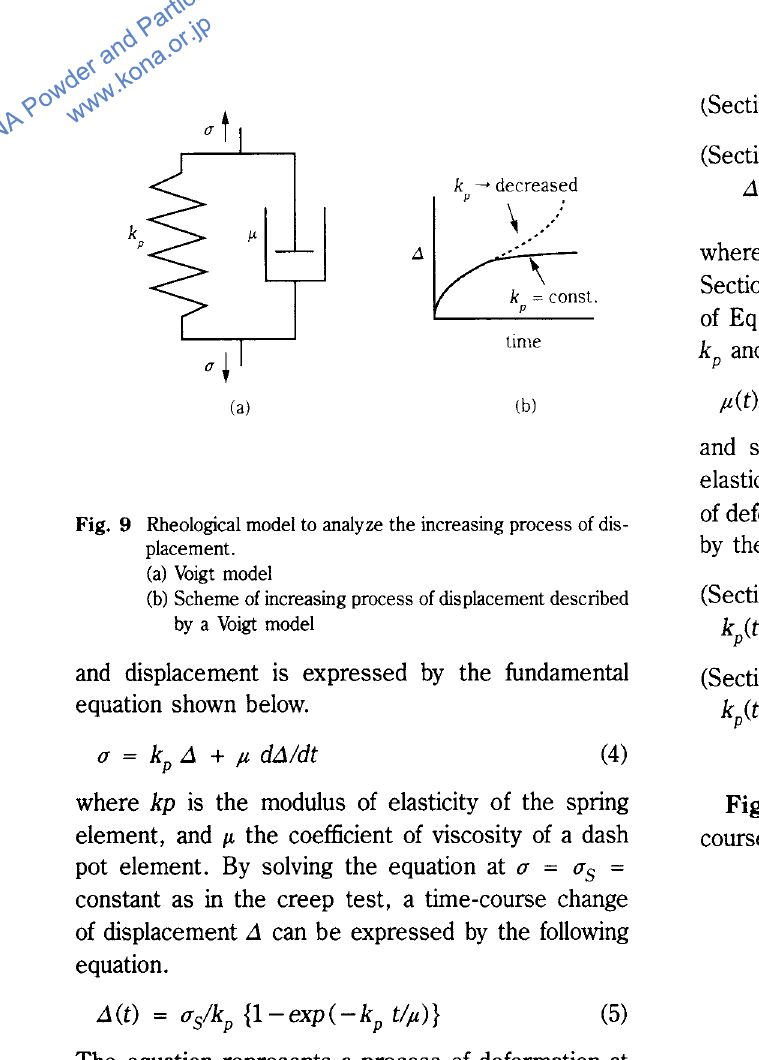
Fig. 9 Rheological model to analyze the increasing process of dis placement. (a) Voigt model (b) Scheme of increasing process of displacement described by a Voigt model